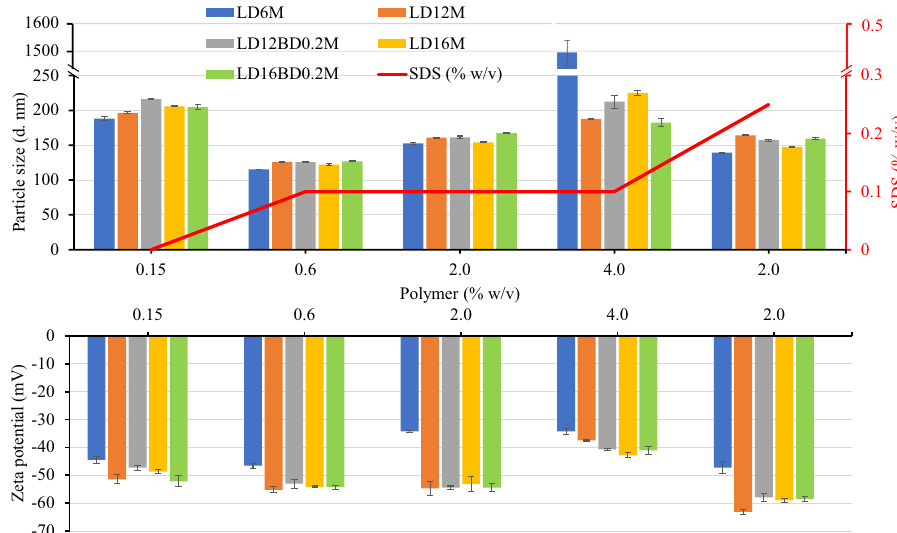
Figure 9. Particle size and Zeta potential of emulsions of alcohol-acidolyzed PLA products fabricated with and without SDS